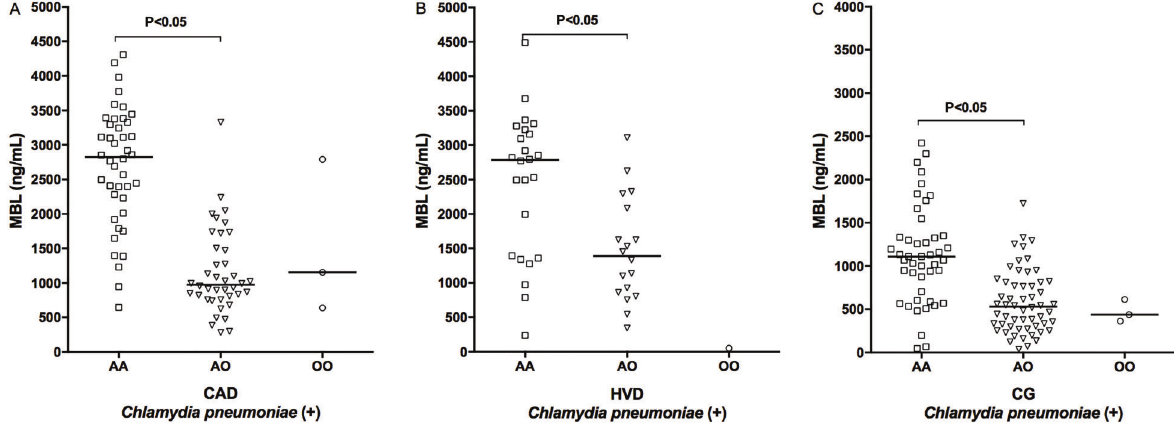
Figure 4. Distribution of mannose-binding lectin (MBL) plasma levels in relation to the genotypes of ( A ) patients with coronary artery disease undergoing coronary artery bypass surgery (CAD), ( B ) patients with heart valve disease undergoing valve replacement (HVD), and ( C ) control group individuals (CG) seropositive only for C. pneumoniae . Data are reported as medians (Mann-Whitney